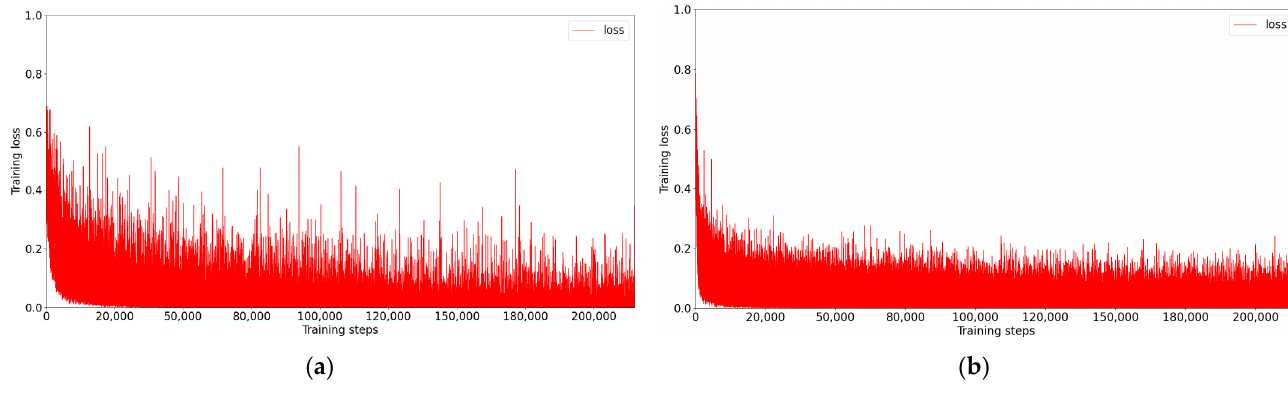
Figure 6. Comparison of losses convergence in pretraining. Note, our aim is not to make a perfor- mance comparison between these two, but rather to explore the wider use of ViT [13] and pretrain- ing for generative tasks from the perspective of a GAN’s discriminator. ( a ) PatchGAN [47] on 128 × 128 patches. ( b ) ViT [13] on 128 × 128 patches.